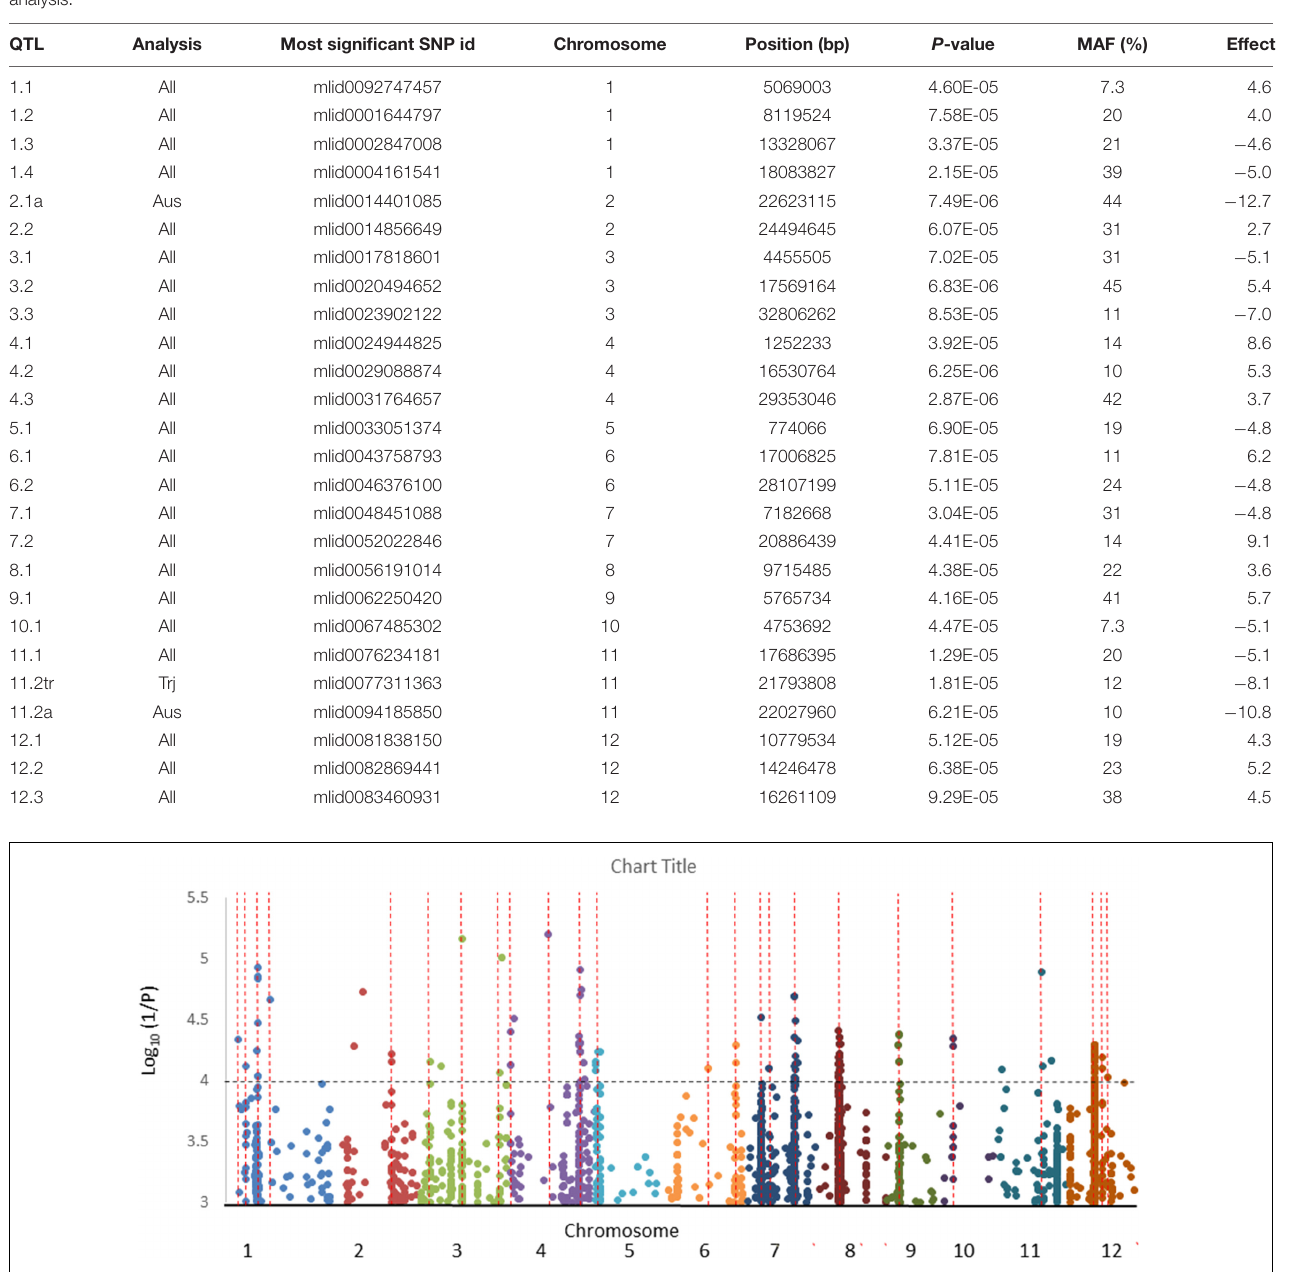
FIGURE 9 | Genome wide association mapping of the All analysis showing only SNPs where P < 0.001. Lines indicate where there is at least one other marker within 200 kb. Each color represents a different